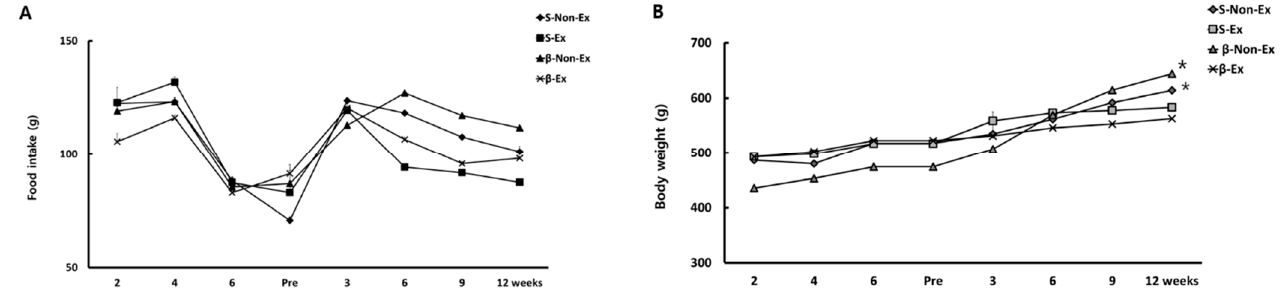
Figure 2. Changes in food intake ( A ) and body weight ( B ) during the obesity-induction period and the 12-week intervention period. (* p < 0.05 Significant difference as compared to Non-Ex group).